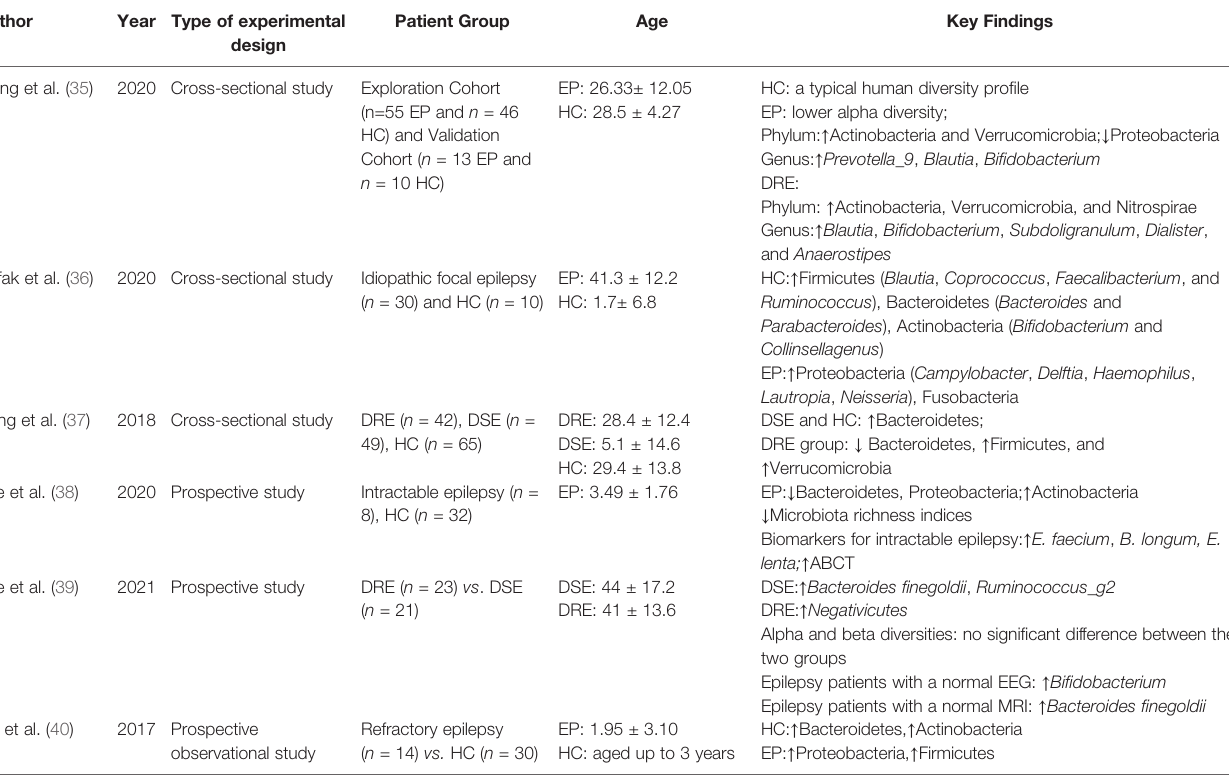
TABLE 1 | Summary of previous studies on the intestinal microbiota in patients with epilepsy